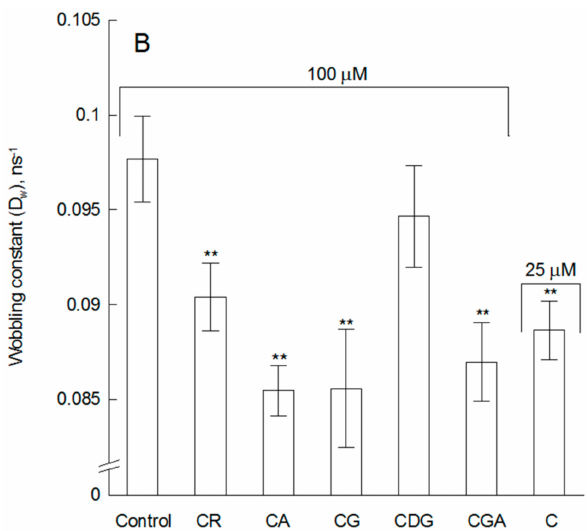
Figure 2. Order parameter (S) ( A ) and wobbling constant ( D w ) ( B ) of DPH probe determined for POPC membrane and POPC with addition of cyanidin used at 25 µ M and its glycosides used and 100 µ M. Statistically significant differences between values determined for control and modified membrane were marked: ** at α =